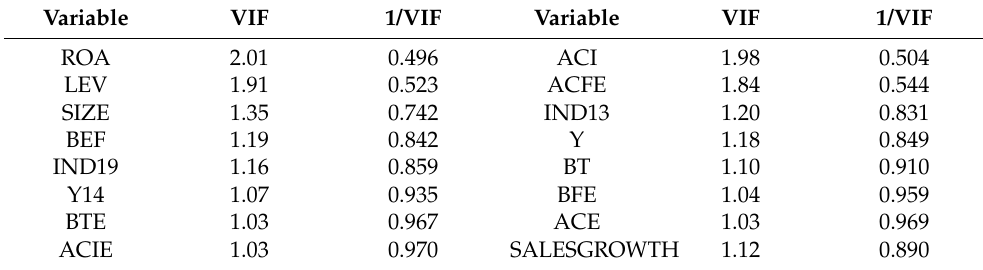
Table 7. The alignment test of the second